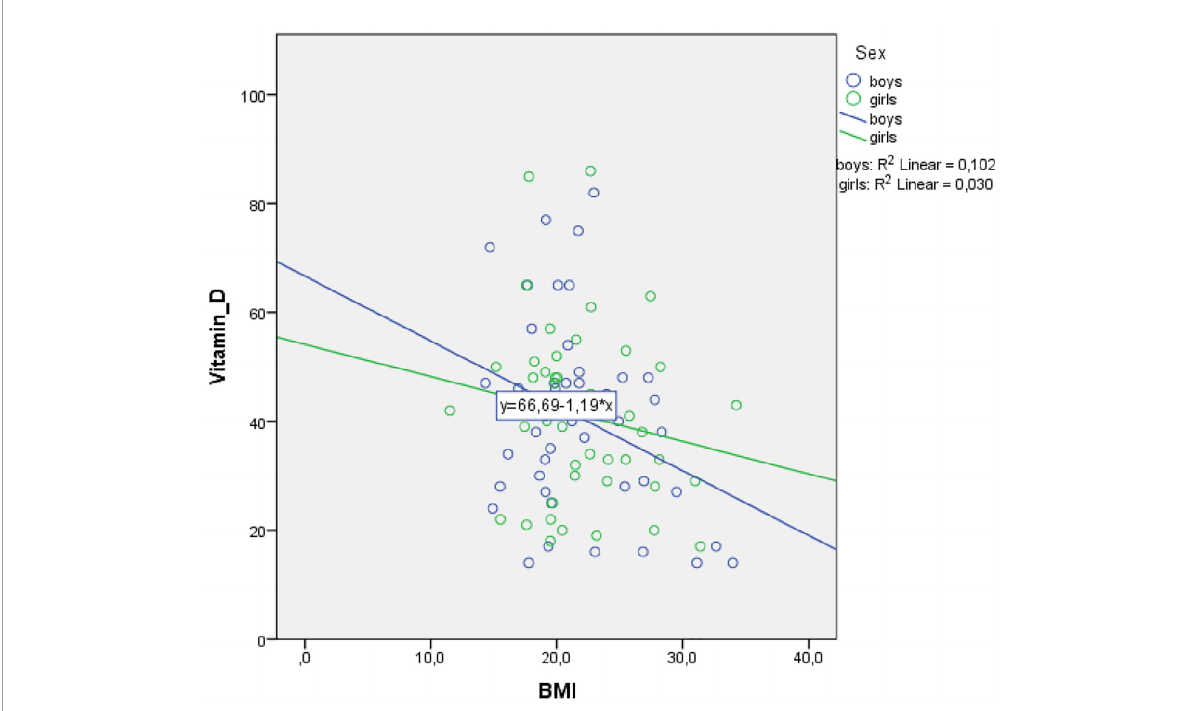
FIGURE2 Scatterplot of vitamin D3 body mass index (BMI) for girls and boys